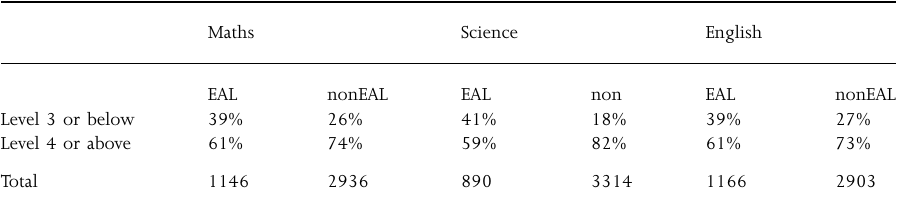
Table 5 Performance at KS2 by EAL